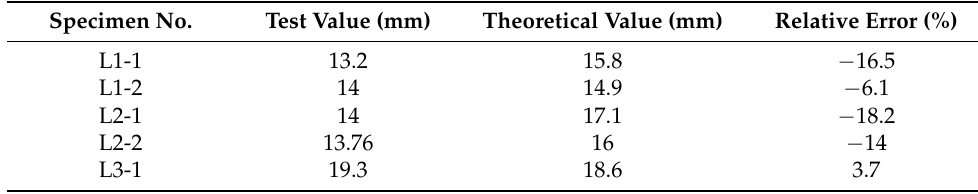
Table 9. Comparison of elastic limit theoretical deflection values with test